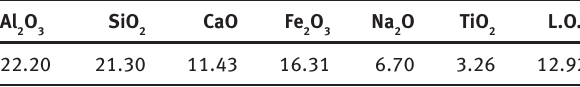
Table 1: Chemical composition of red mud (%wt).